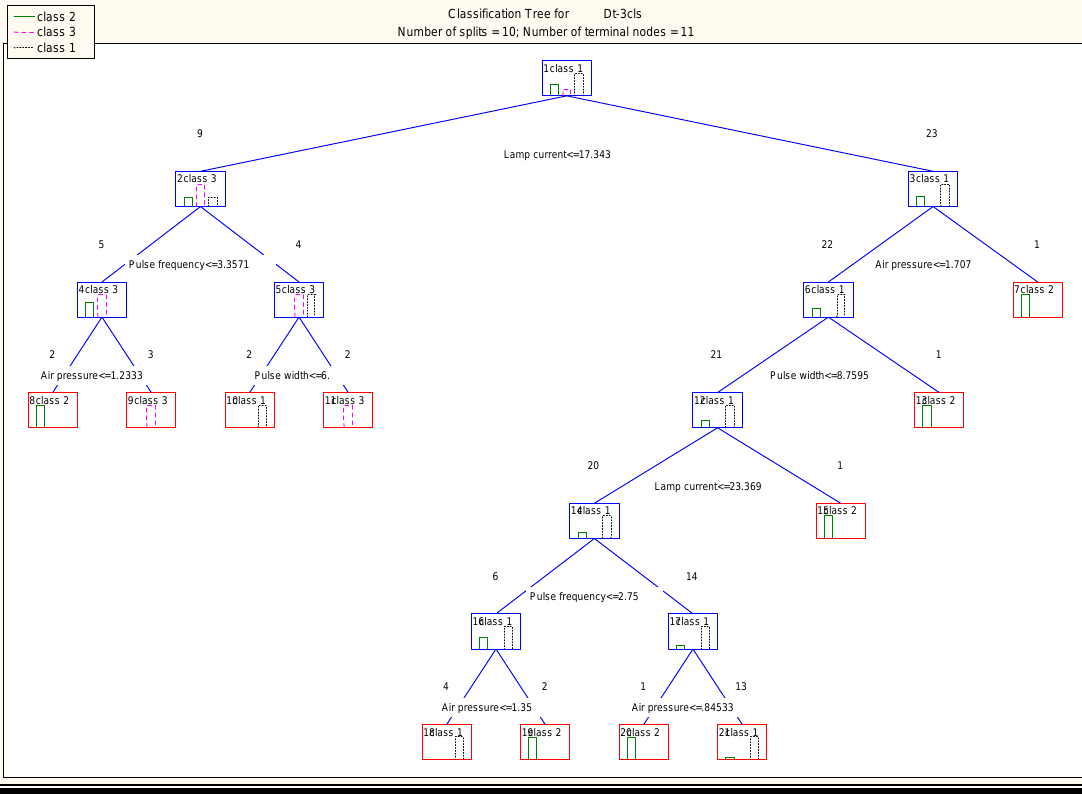
Fig. 11. Decision tree for deviation of taper (three